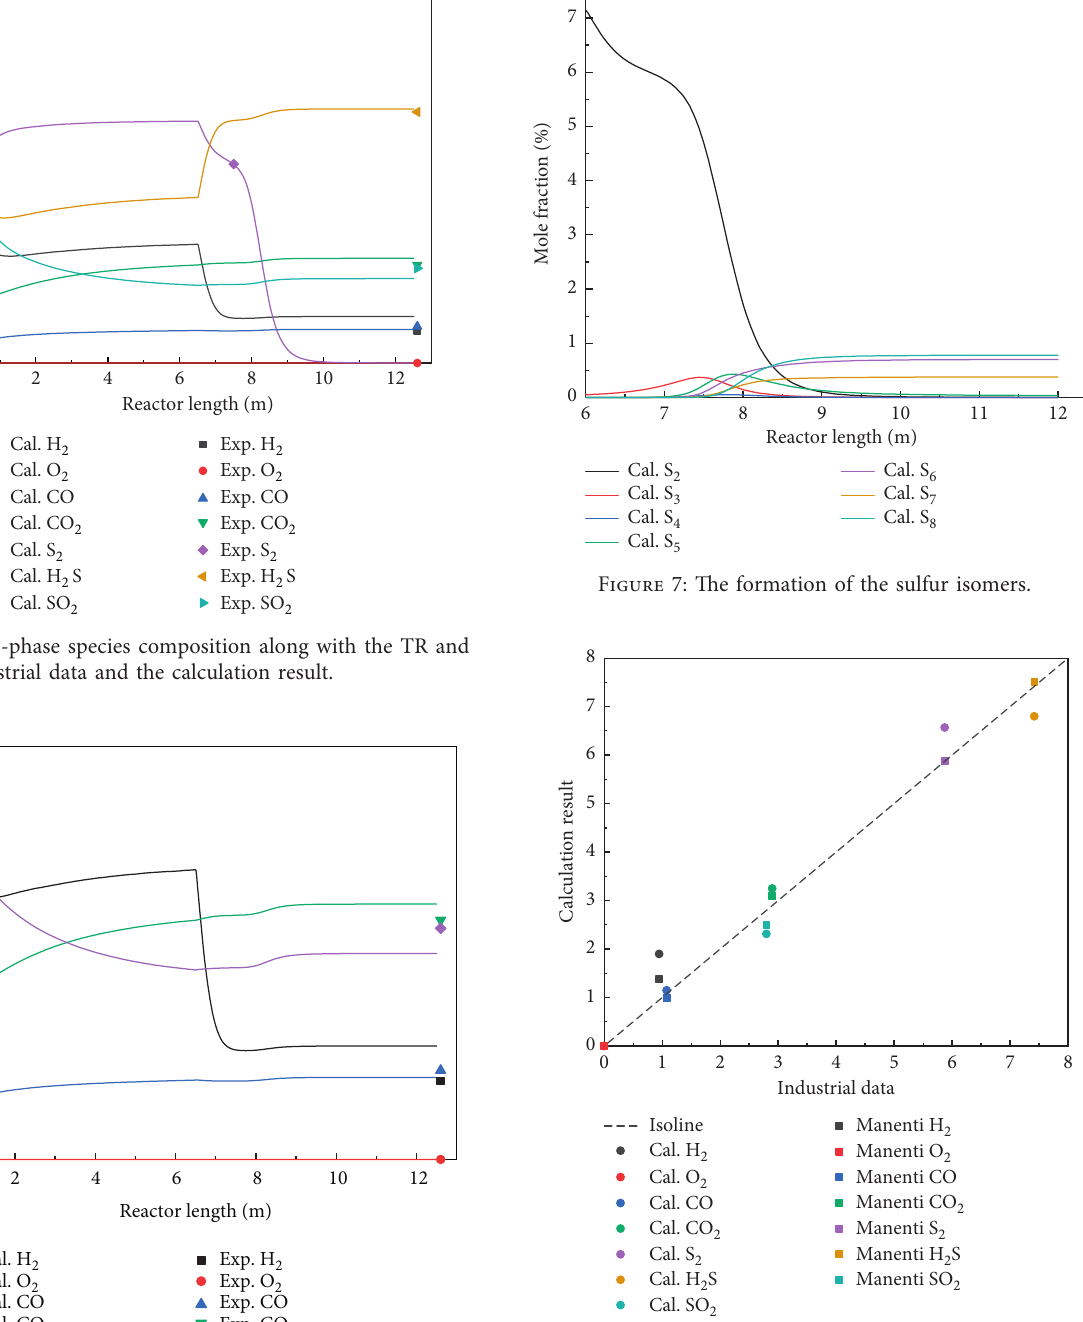
Figure 8: The residuals of the calculated